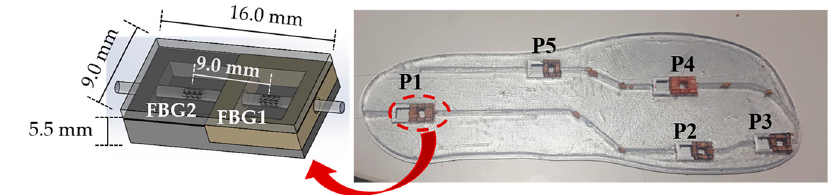
Figure 8. Photograph of the insole used for shear and plantar pressure monitor, incorporating five FBGs cells (as also schemed).